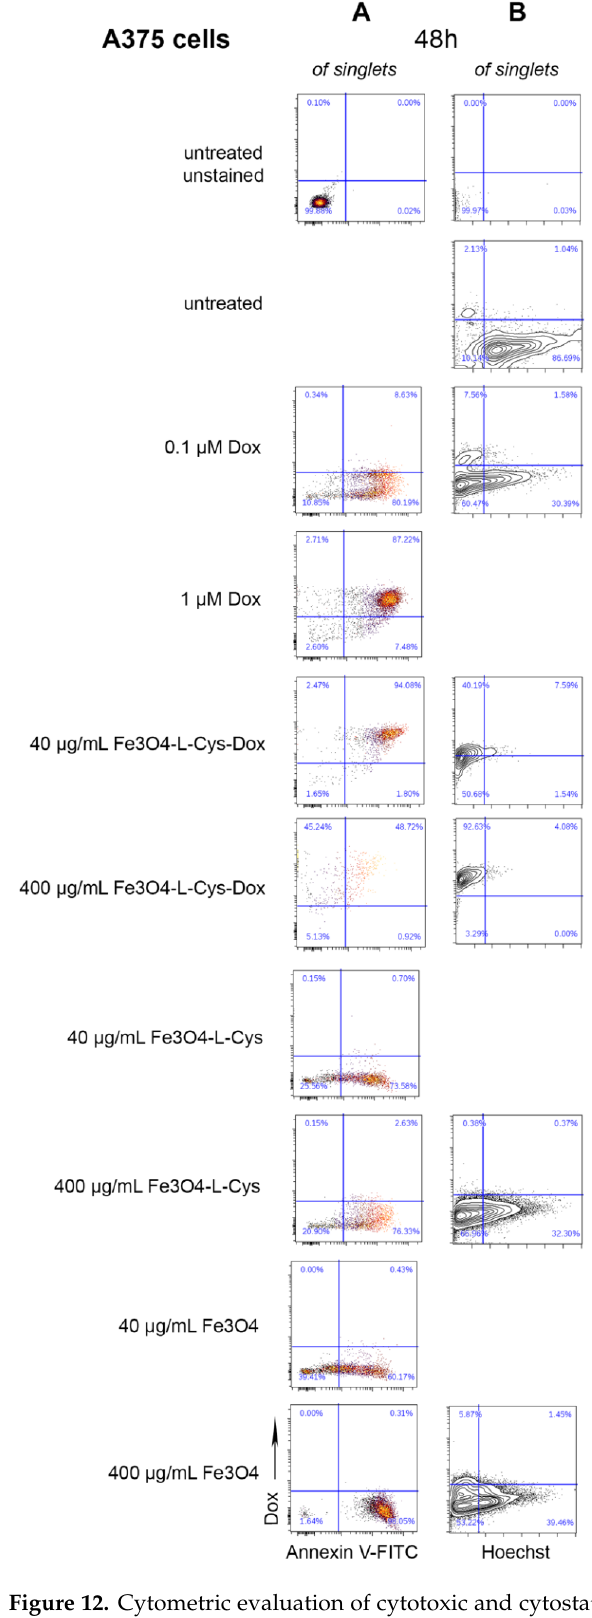
Figure 12. Cytometric evaluation of cytotoxic and cytostatic potential of Fe 3 O 4 , Fe 3 O 4 -L-Cys and Fe 3 O 4 -L-Cys-Dox NPs. Analysis of the percentage of cells in apoptosis ( A ) and the cell cycle profile ( B ) following 48 h treatment with NPs or free Dox in human A375 melanoma